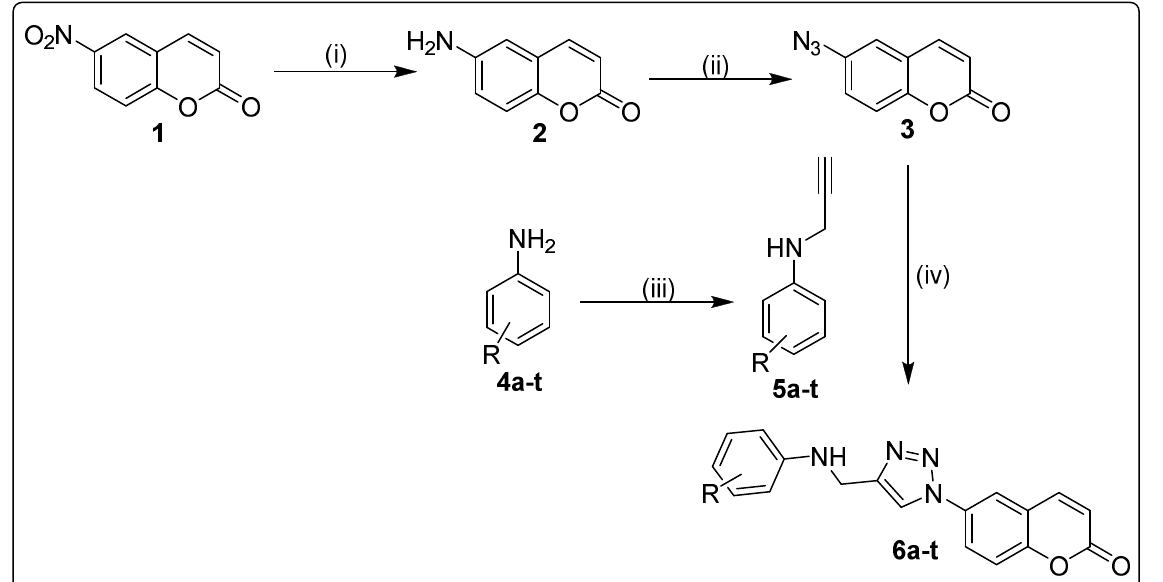
Figure 1. General structure of the compounds reported in the